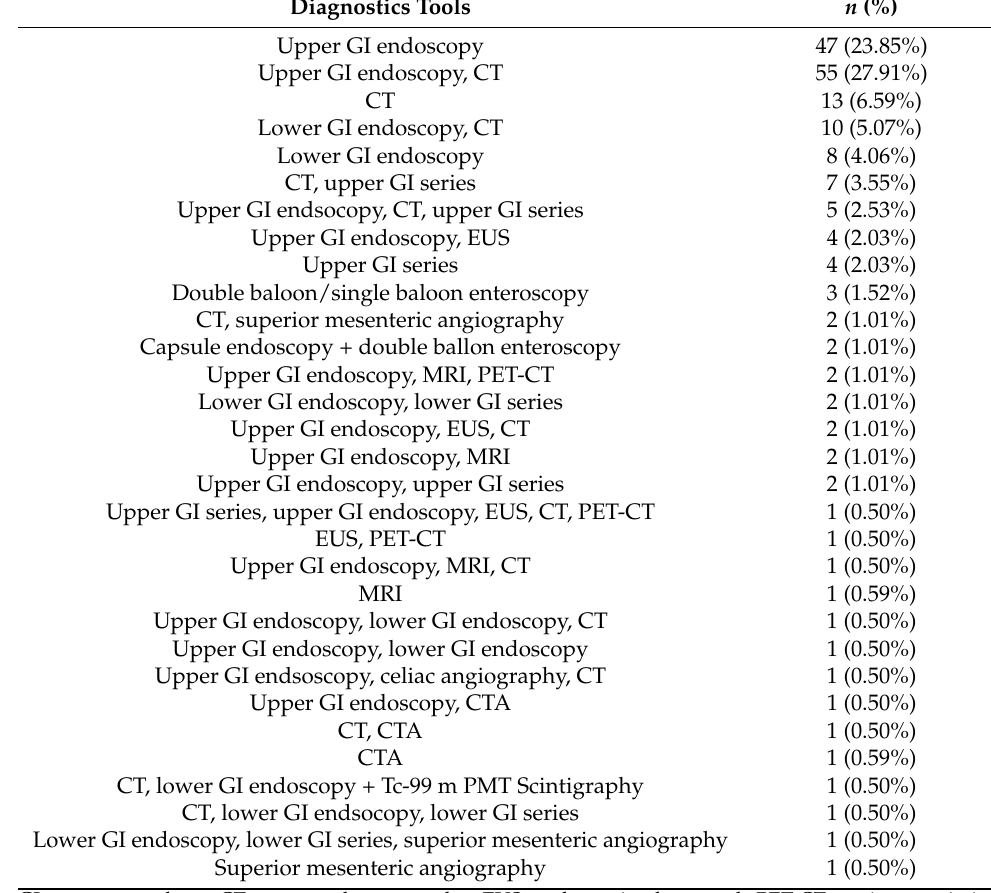
Table 8. Palette of diagnostic tools used for GI